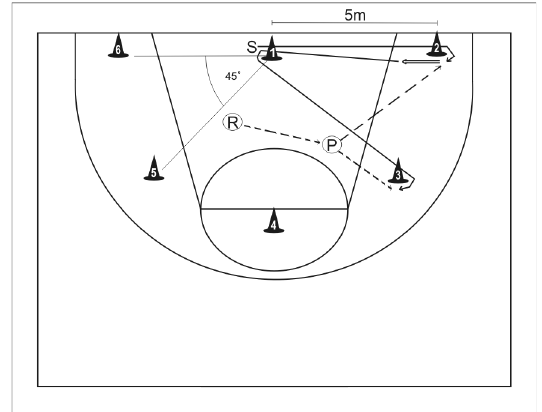
Figure 5. The dynamic 60-second three-point shooting test (S3P60) Legend. R = rebounder, P = passer, S =